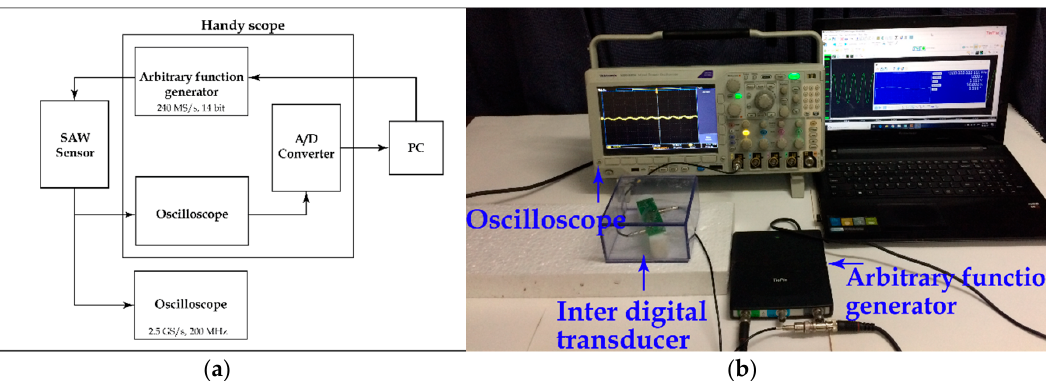
Figure 3. ( a ) Schematic representation for generation of SAWs and longitudinal waves using IDT sensors and ( b ) experimental setup for conducting excitation and detection of SAWs using IDT sensor in LiNbO 3